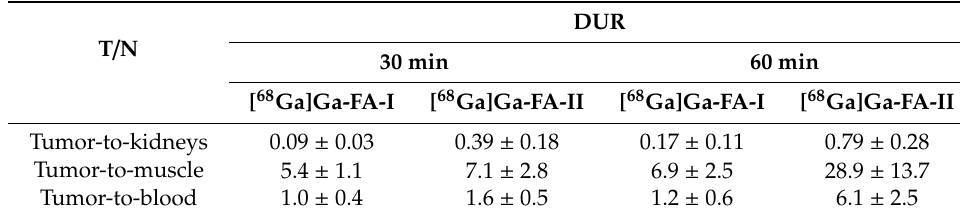
Figure 5. Biodistribution of [ 68 Ga] Ga-FA-I and [ 68 Ga] Ga-FA-II in KB-tumor bearing BALB/c nude mice 30 and 60 min after i.v. injection (selected organs/tissues from Table 3 ). Table 4. Differential uptake ratio (DUR) for [ 68 Ga] Ga-FA-I and [ 68 Ga] Ga-FA-II 30 and 60 min post injection in KB-tumor xenografts ( mean ± SD, n = 5 ).